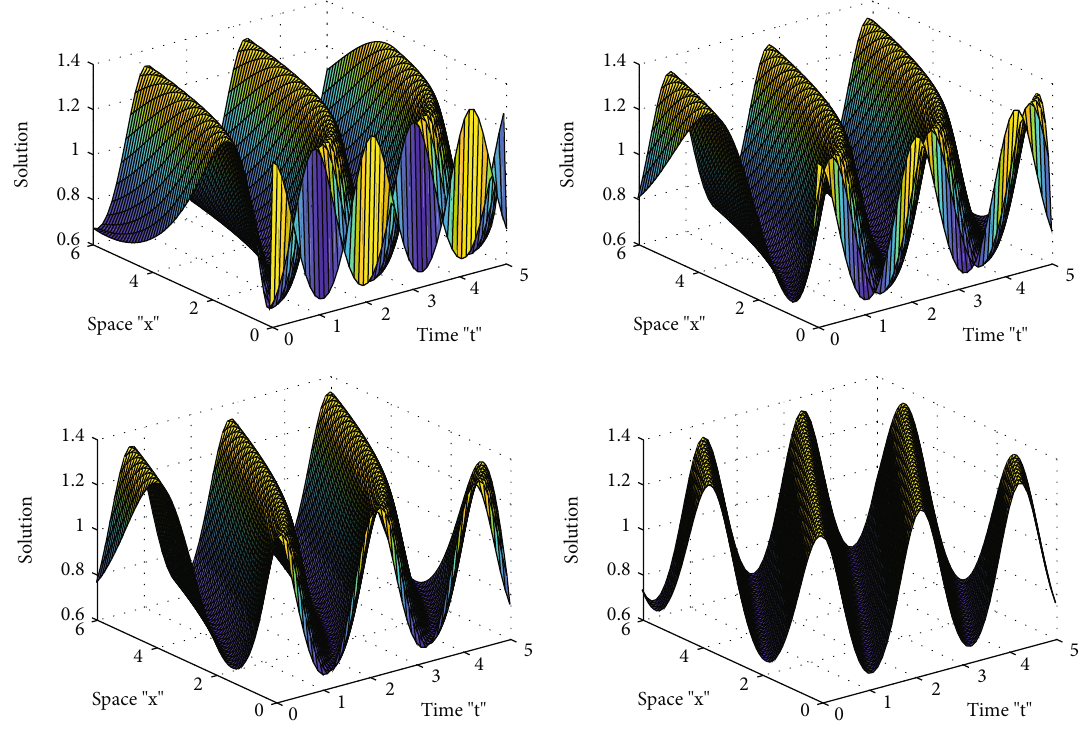
Figure 4: 3D plot of Equation (29) with σ = 0 and di ff erent α